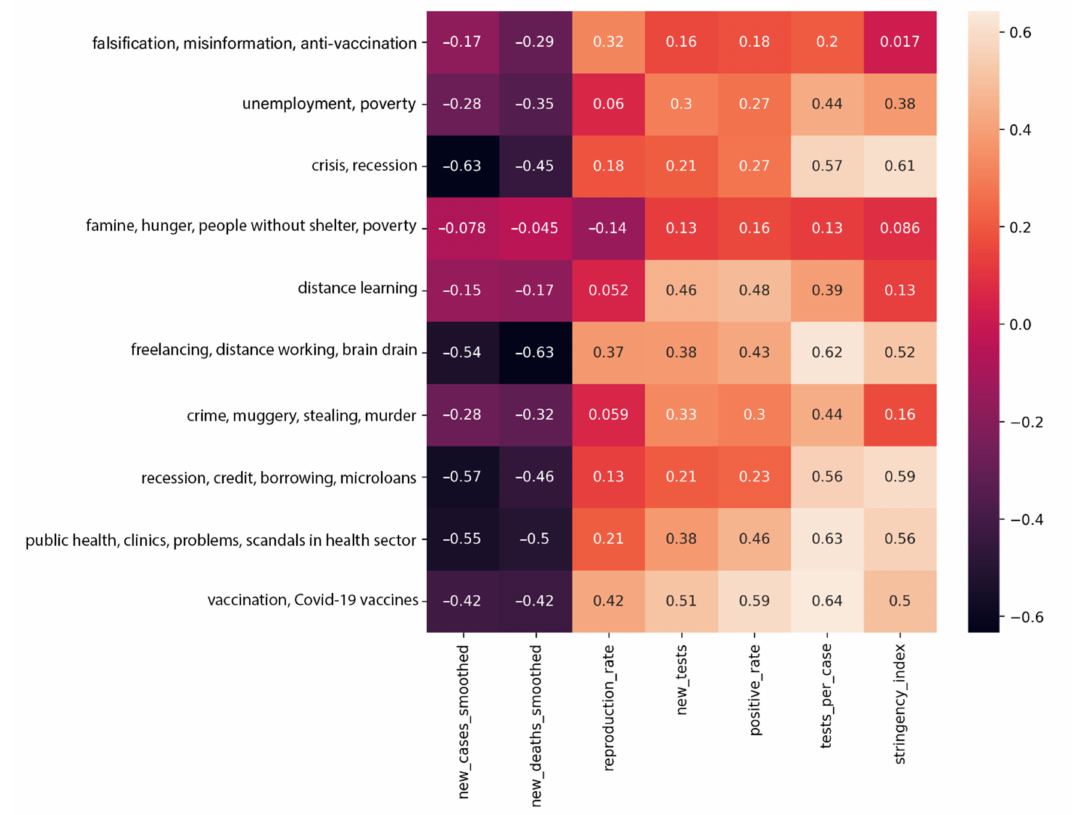
Figure 4. Correlation between the dynamics of search query activity (vertical) and pandemic rates (bottom horizontal: variables new_cases_smoothed, new_deaths_smoothed,